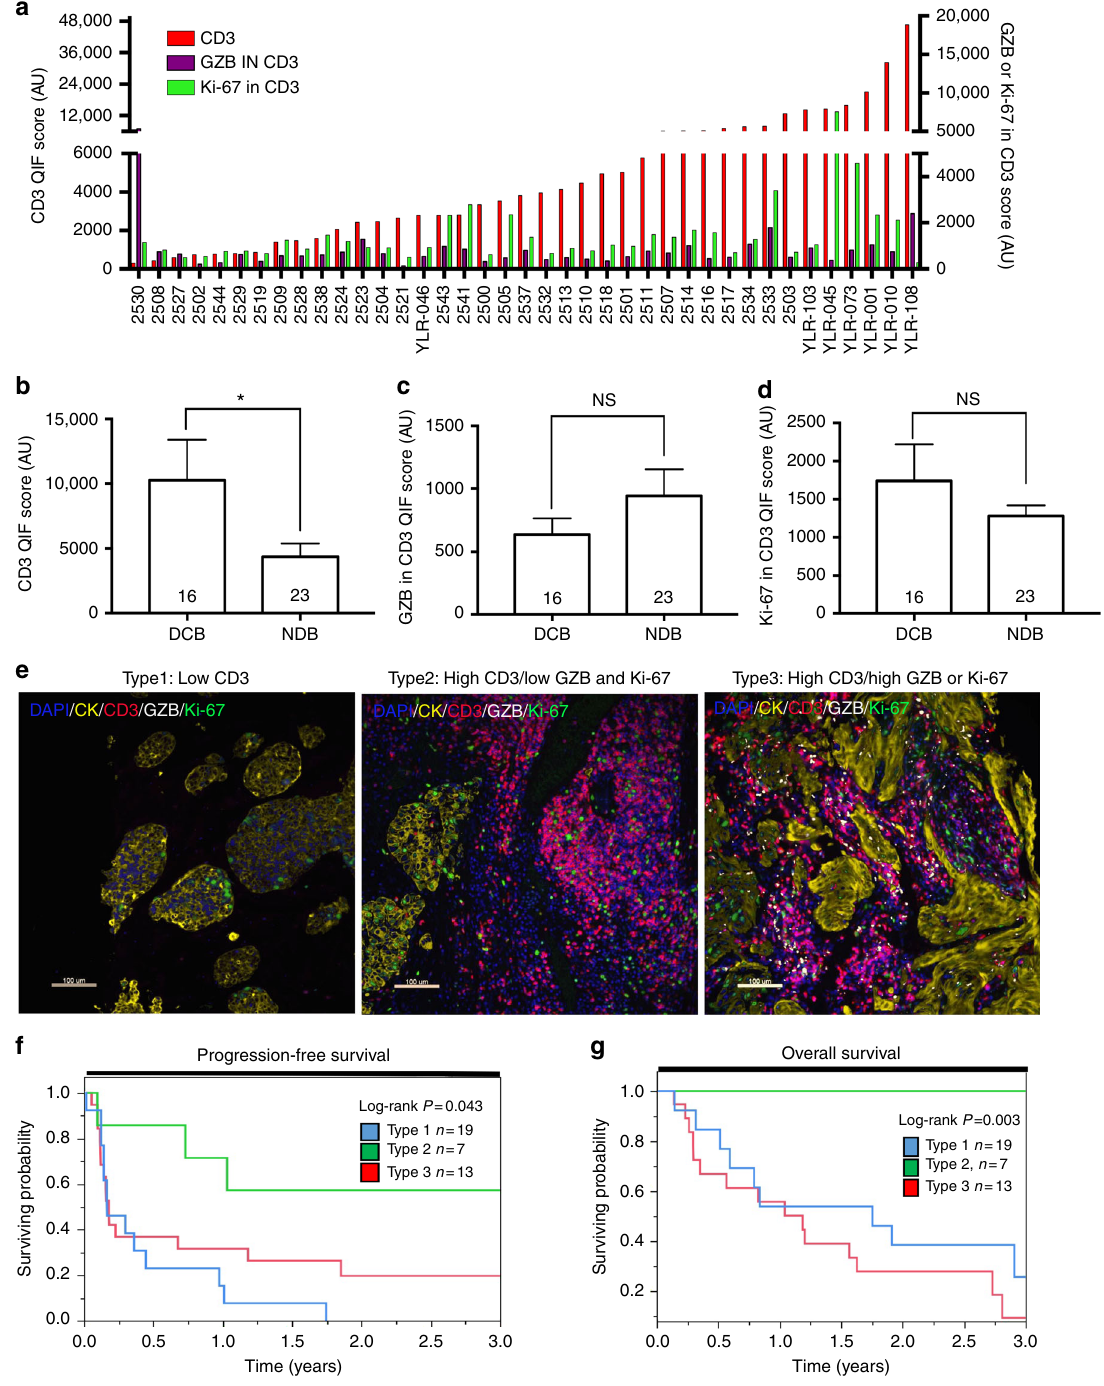
Fig. 4 Association between local T-cell in fi ltration and activation/proliferation and bene fi t from immune checkpoint blockers in NSCLC. a Distribution of in situ CD3 (red, left Y axis), T-cell GZB (magenta, right Y axis) and T-cell Ki-67 signal (green, right Y axis) in lung tumors from patients treated with immune checkpoint blockers. b – d Association between the level of CD3 ( b ), T-cell GZB ( c ), and T-cell Ki-67 ( d ) with durable clinical bene fi t (DCB) or no durable bene fi t (NDB) to immune checkpoint blockade. The number of cases in each group is indicated within each bar. NS = not signi fi cant with Mann- Whitney P > 0.05. *Mann – Whitney P value . Error bars indicate S.E.M. e Representative multiplexed fl uorescence pictures showing lung tumors with a type 1 TIL pattern containing low CD3 level (left panel), a type 2 pattern with high CD3 but low T-cell GZB/Ki-67 (center panel); and a type 3 TIL phenotype with high CD3 and elevated T-cell GZB/Ki-67 (right panel). The color assigned to each marker is indicated within each caption. Bar = 100 μ m. f , g Kaplan – Meier graphical analysis of 3-year progression free survival ( f ) and overall survival ( g ) of lung cancer cases treated with immune checkpoint blockers according to their TIL phenotype panel. The number of cases in each group and the log-rank P value is indicated in the